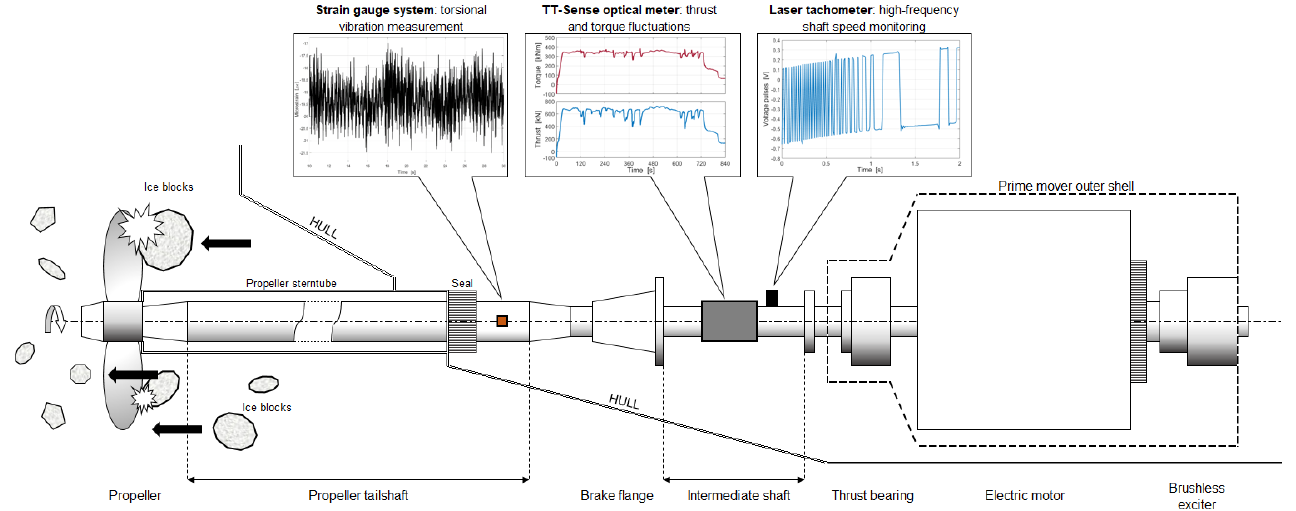
Figure 2. Shaft instrumentation installed on the Starboard shaftline of CCGS Henry